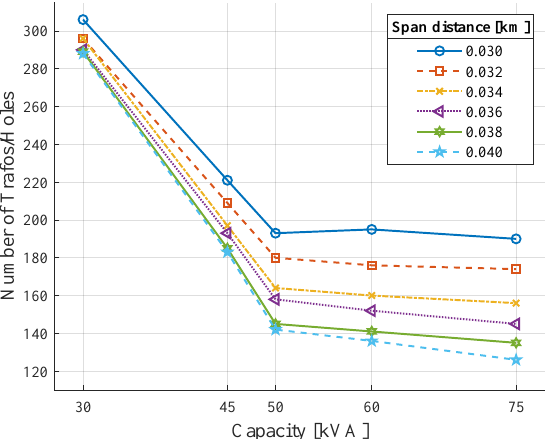
Figure 4. Modified Prim algorithm with capacity and span constraints.